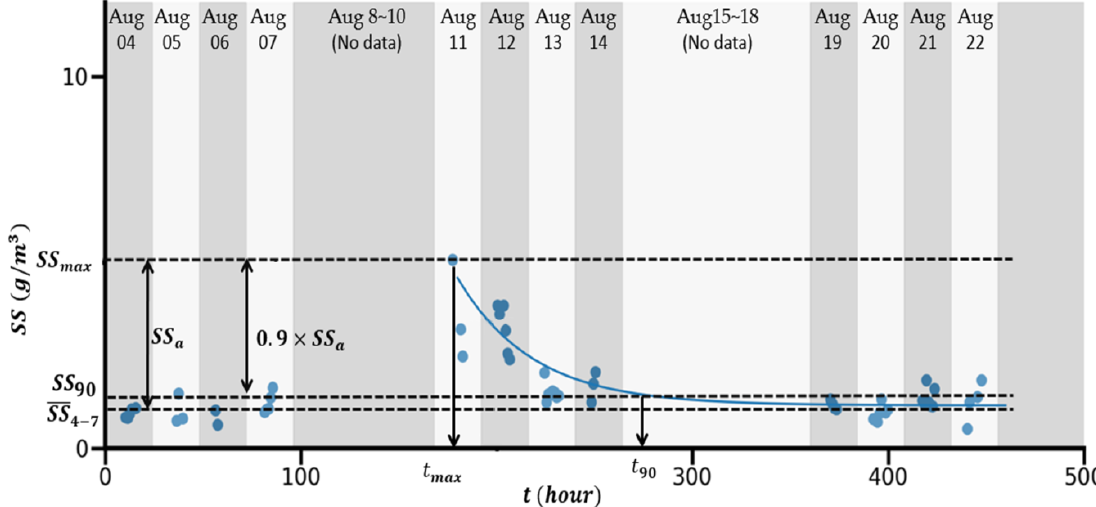
Figure 3. Example of temporal decay of suspended sediment ( SS ). Corresponding 𝑆𝑆 90 with 𝑡 90 are denoted.